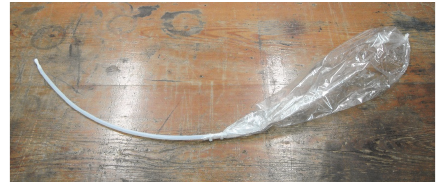
Figure 1: Nalophan sampling bag, capacity 6